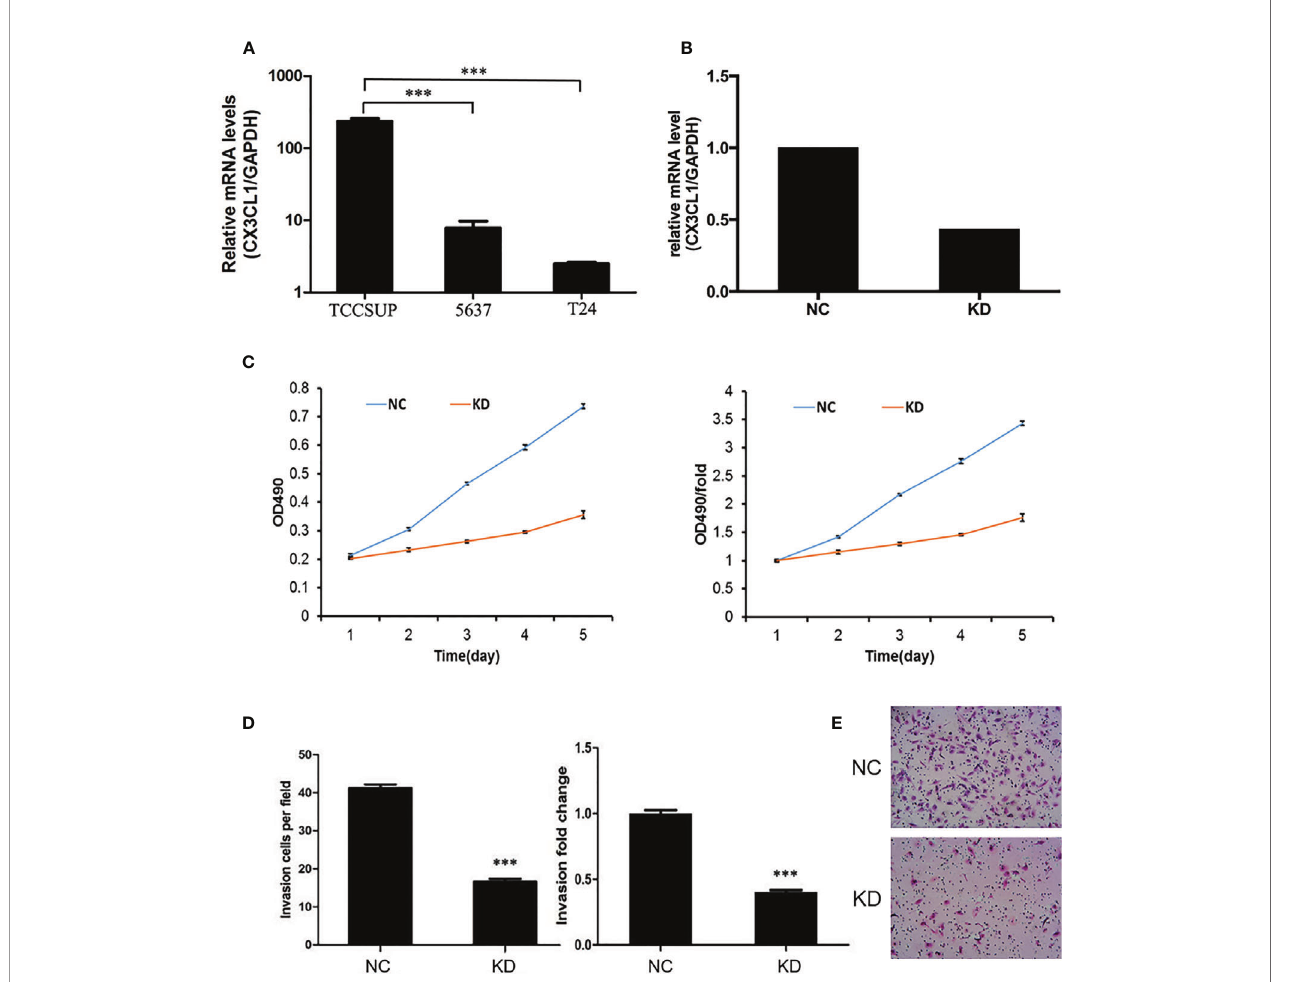
FIGURE 2 | (A) The mRNA expression of CX3CL1 in TCCSUP, 5637 and T24 cells. The mRNA expression of CX3CL1 in TCCSUP cells was signi fi cantly higher than that in 5637 and T24 cells. (B) Difference in CX3CL1 mRNA levels between NC and KD TCCSUP cells. The CX3CL1 gene of TCCSUP cells in KD group was knocked down, and the knockdown rate was veri fi ed by qPCR. (C) Difference in TCCSUP cell proliferation between NC and KD groups determined by the MTT method. The results showed that cell proliferation in the KD group(Orange line) was signi fi cantly decreased. (D, E) Cell invasion of NC and KD cells determined by Transwell assays. The results showed that after CX3CL1 was knocked down, cell invasion in the KD group was signi fi cantly reduced. ***P <